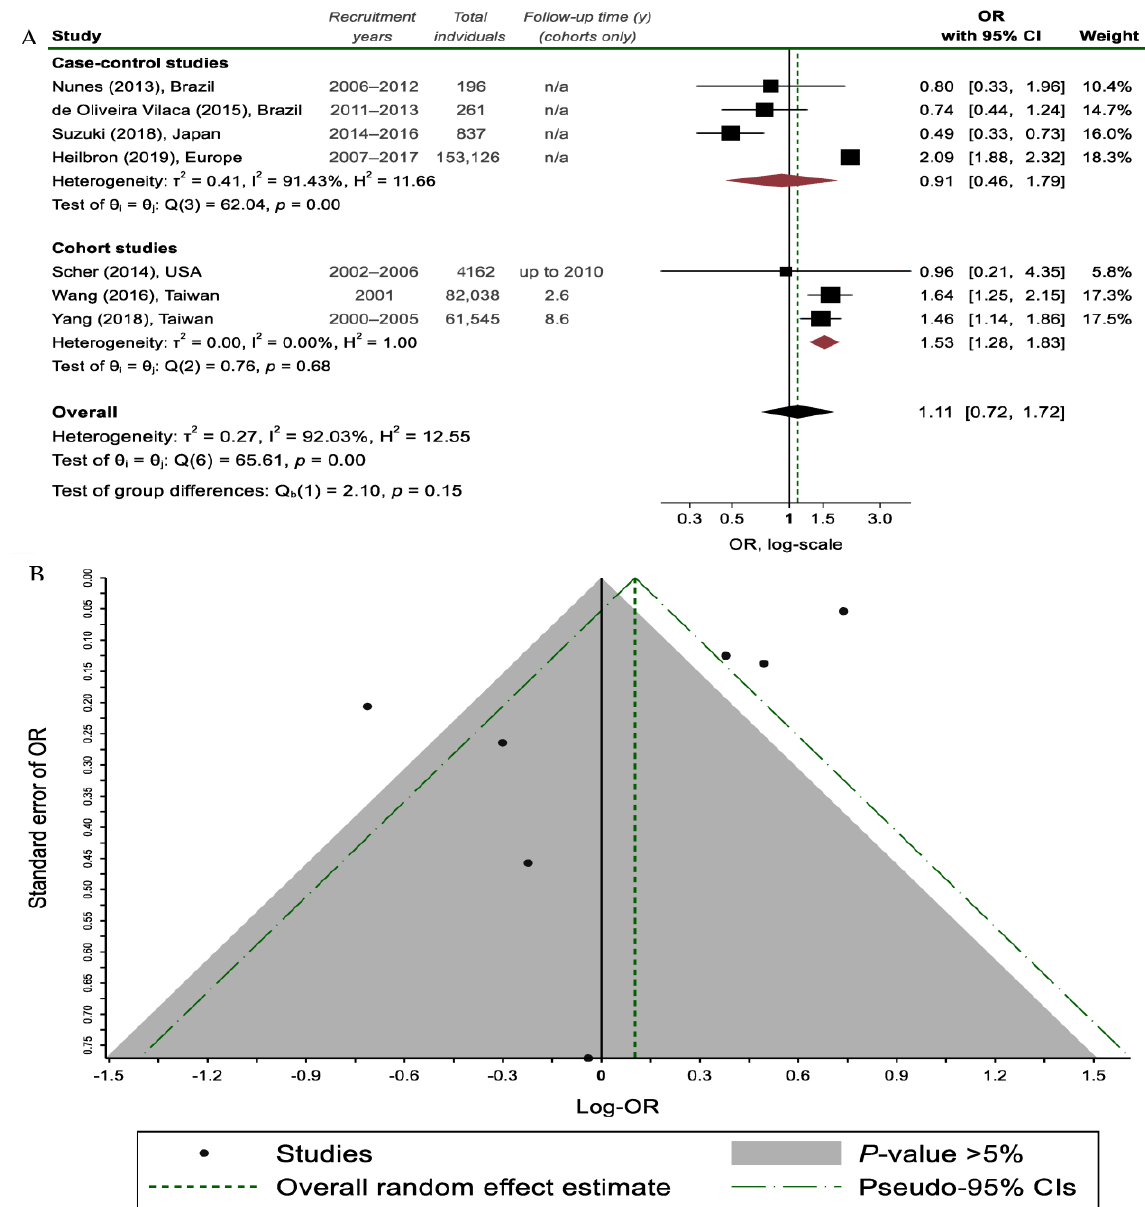
Figure 3. ( A ) Random effects meta-analysis on the association between migraine headaches and Parkinson ’s disease (PD) status stratified by study design; ( B ) Funnel plot, where each study is depicted as a dot. The light grey shaded area contains studies with non-significant results ( p > 0.05) [7,9,15,22,27,31,32].